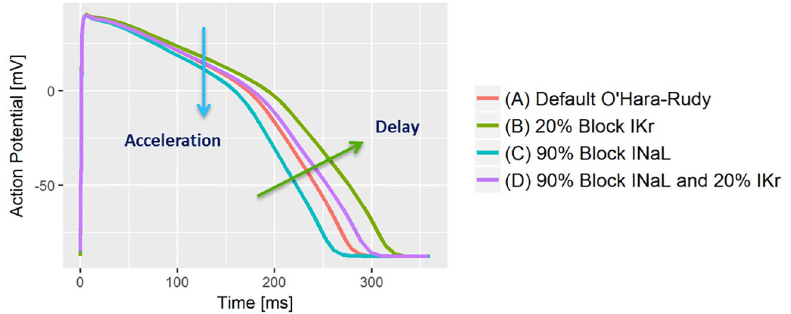
Fig 10. Simulation of blocking of the late sodium (INaL) and the hERG/IKr currents in the O’Hara-Rudy model using the endocardial cell type. Blocking INaL accelerates the repolarization process by increasing the downslope in AP phase 2. Blocking IKr decreases the downslope of the AP in both, phase 2 and phase 3, resulting in delayed repolarization. In simultaneous blocking, the effects compensate in phase 2 but a delay in phase 3 is still